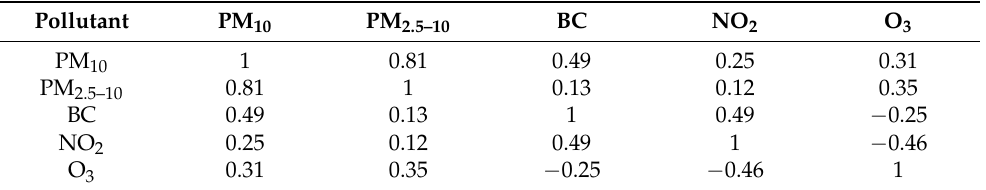
Table A2. Correlation matrix with R-values (Pearson correlation coefficients) between the different air pollutants measured in Stockholm during the whole year during the period from 2000 to 2016.